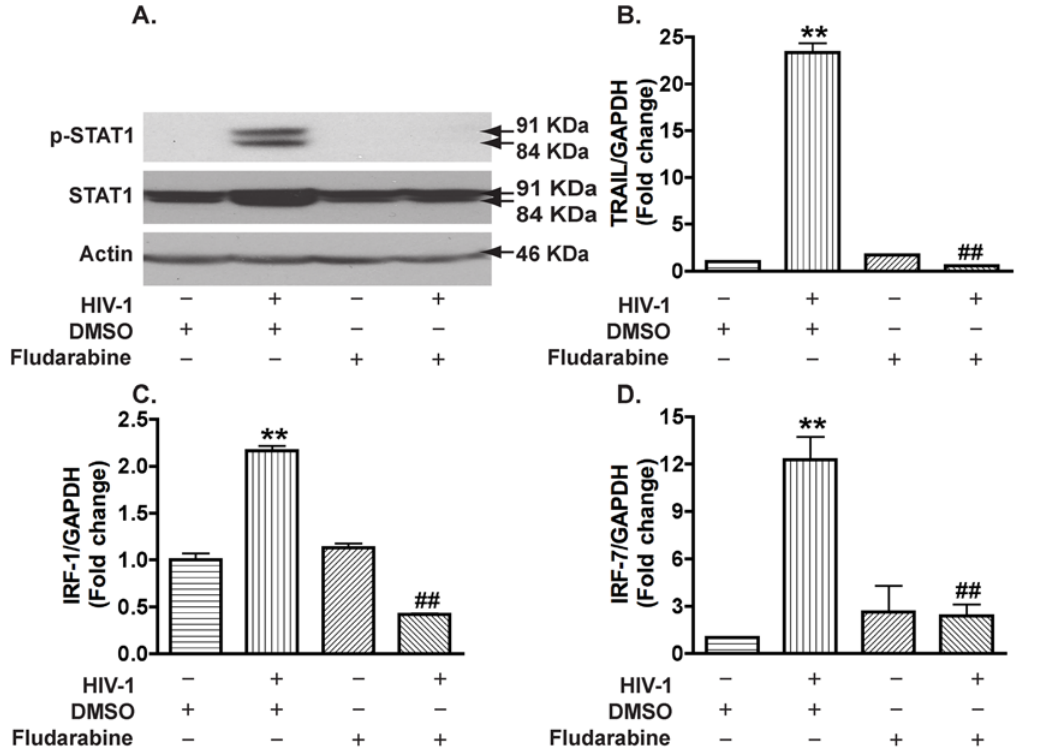
Figure 7. Fludarabine blocks HIV-1-induced STAT1 activation and gene expression of IRF-1, IRF-7, and TRAIL in macrophages. A. MDM were treated with fludarabine at 1 m M 3 days after infection. P-STAT1 and total STAT1 were detected by Western blotting at 5 days after infection. b -actin was used as a loading control. B–D. Real-time RT-PCR was used to detect TRAIL (B), IRF-1 (C), and IRF-7 (D). **, p , 0.05 compared with DMSO control. ## ; p , 0.01 compared to DMSO-treated HIV-1